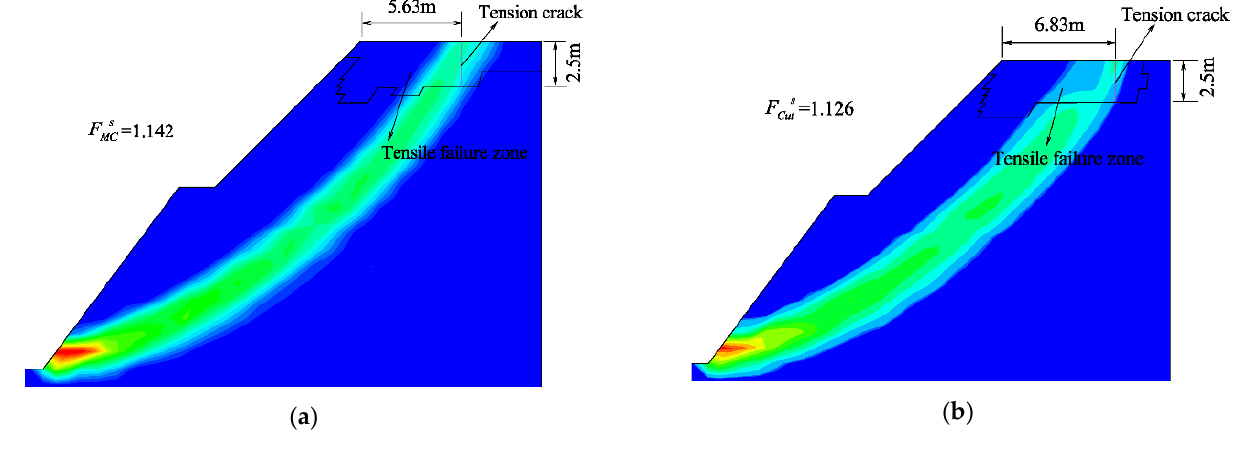
Figure 11. Failure mechanisms. ( a ) intact M–C; ( b ) cut-off M–C.